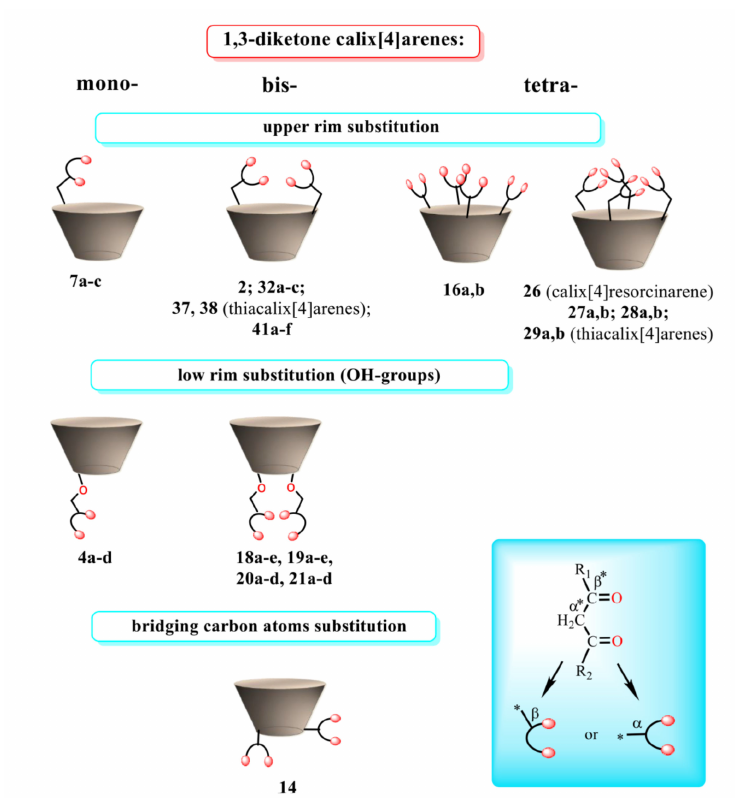
Figure 2. Schematic presentation of 1,3-diketone calix[4]arenes with different embedding modes of 1,3-diketone groups onto cyclophanic